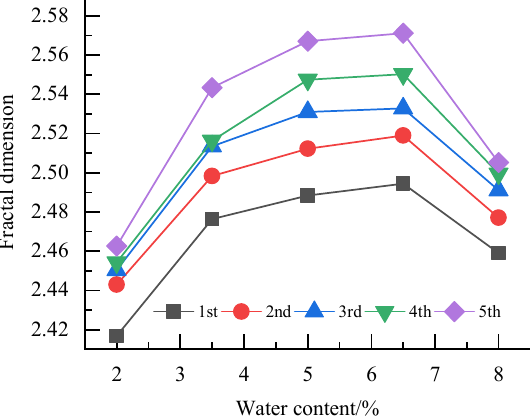
Figure 9. Distribution of the fractal dimension against the water content.